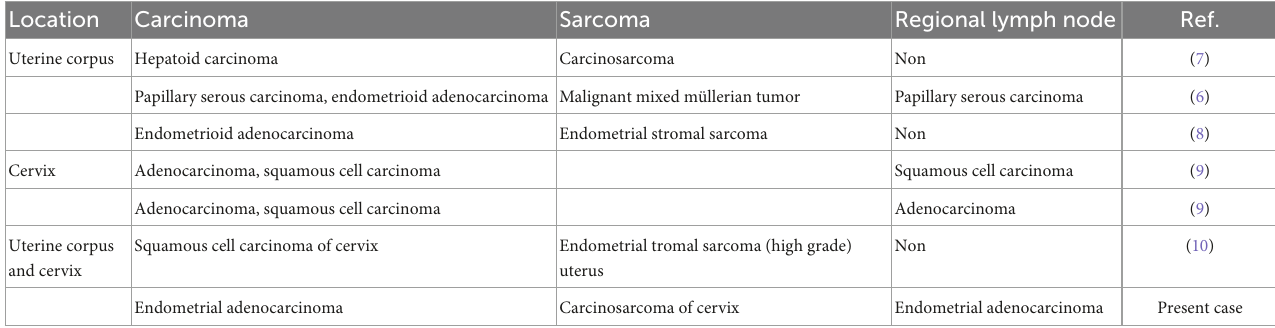
TABLE 1 Summary of previously reported collision tumors of the uterine.